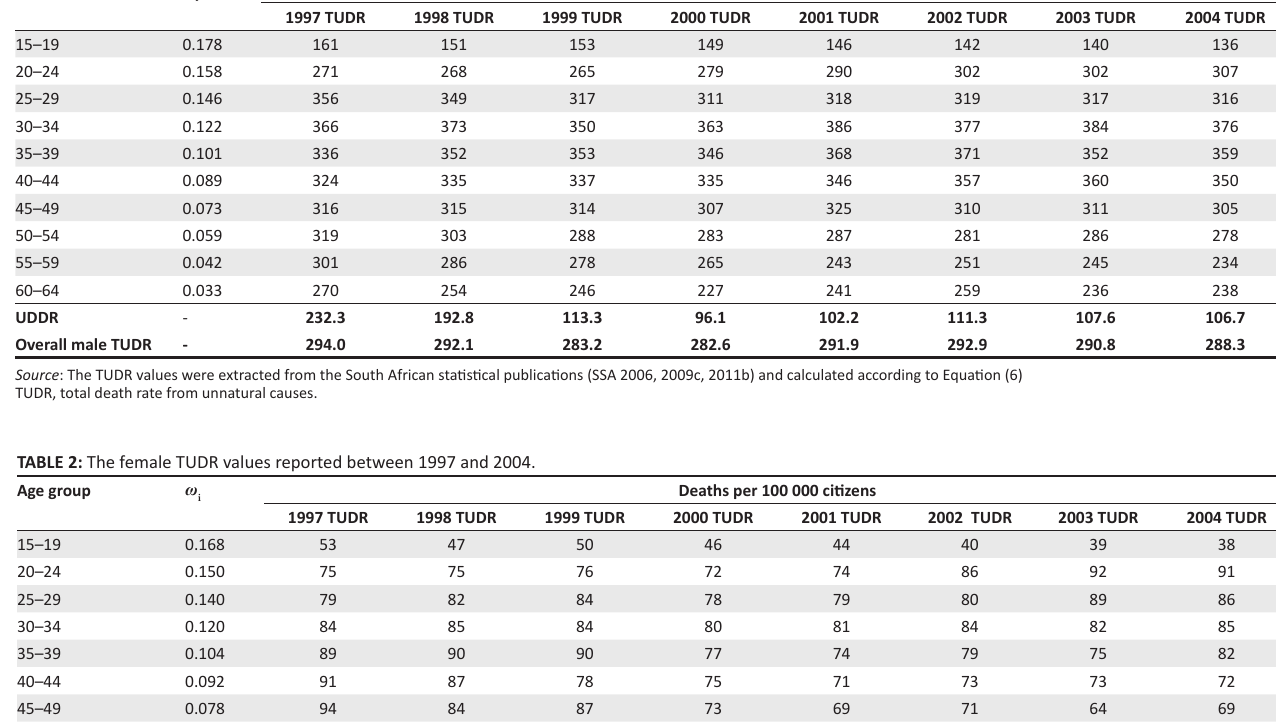
TABLE 1: The male TUDR values reported between 1997 and 2004. Age group